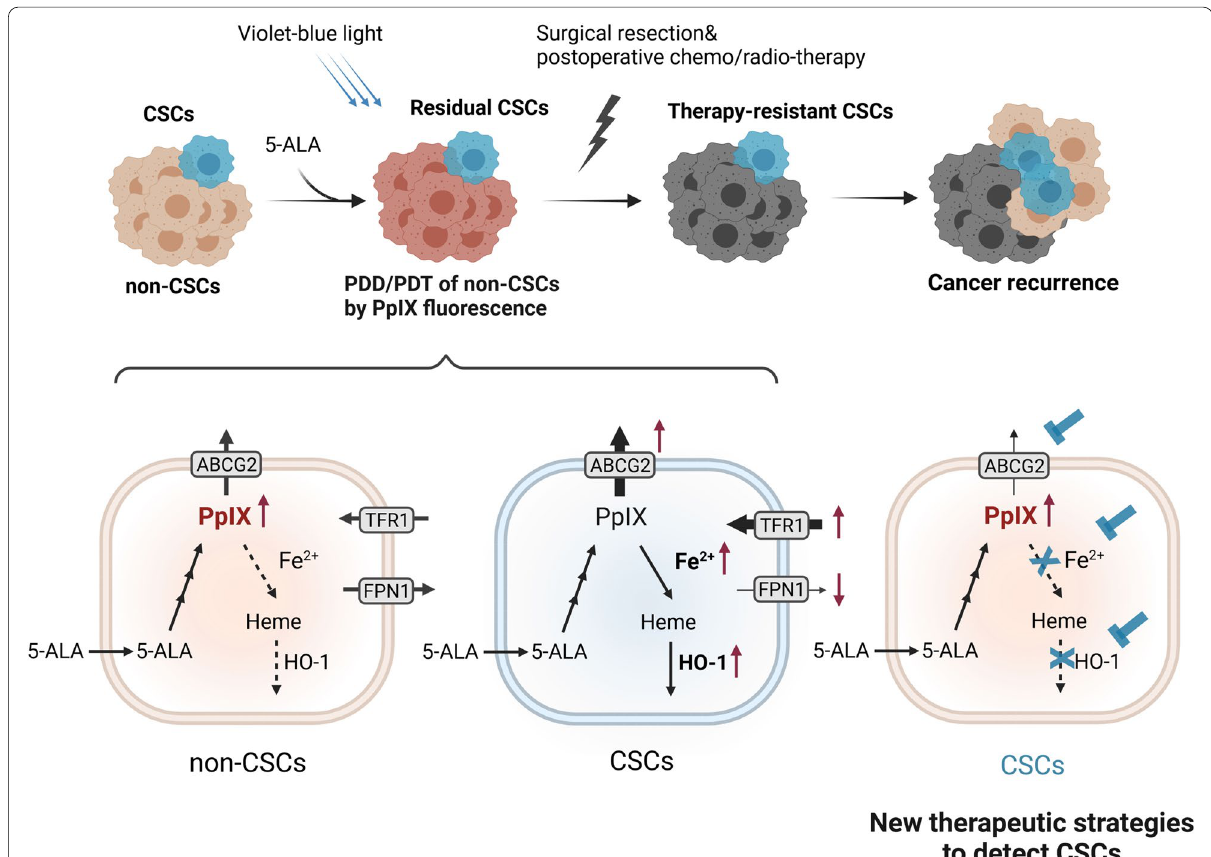
Fig. 2 The current limitations and new therapeutic strategies of 5-ALA-based PDD/PDT to detect CSCs for cancer eradication. CSCs exhibit lower PpIX accumulation in 5-ALA-based PDD/PDT, potentially due to PpIX efflux by ABCG2 transporter, accelerated iron usage to convert PpIX to heme and the increased expression of HO-1 to accelerate PpIX-heme metabolism. The combination of 5-ALA-PDD/PDT with targeted proteins in heme/ iron metabolism might establish the novel therapeutic strategies to eradicate CSCs. ABCG2, ATP-binding cassette sub-family G member 2; 5-ALA, 5-aminolevulinic acid; FPN1, ferroportin1; PDD, photodynamic diagnosis; PDT, photodynamic therapy; PpIX, protoporphyrin IX; TFR1, transferrin receptor 1; HO-1, heme